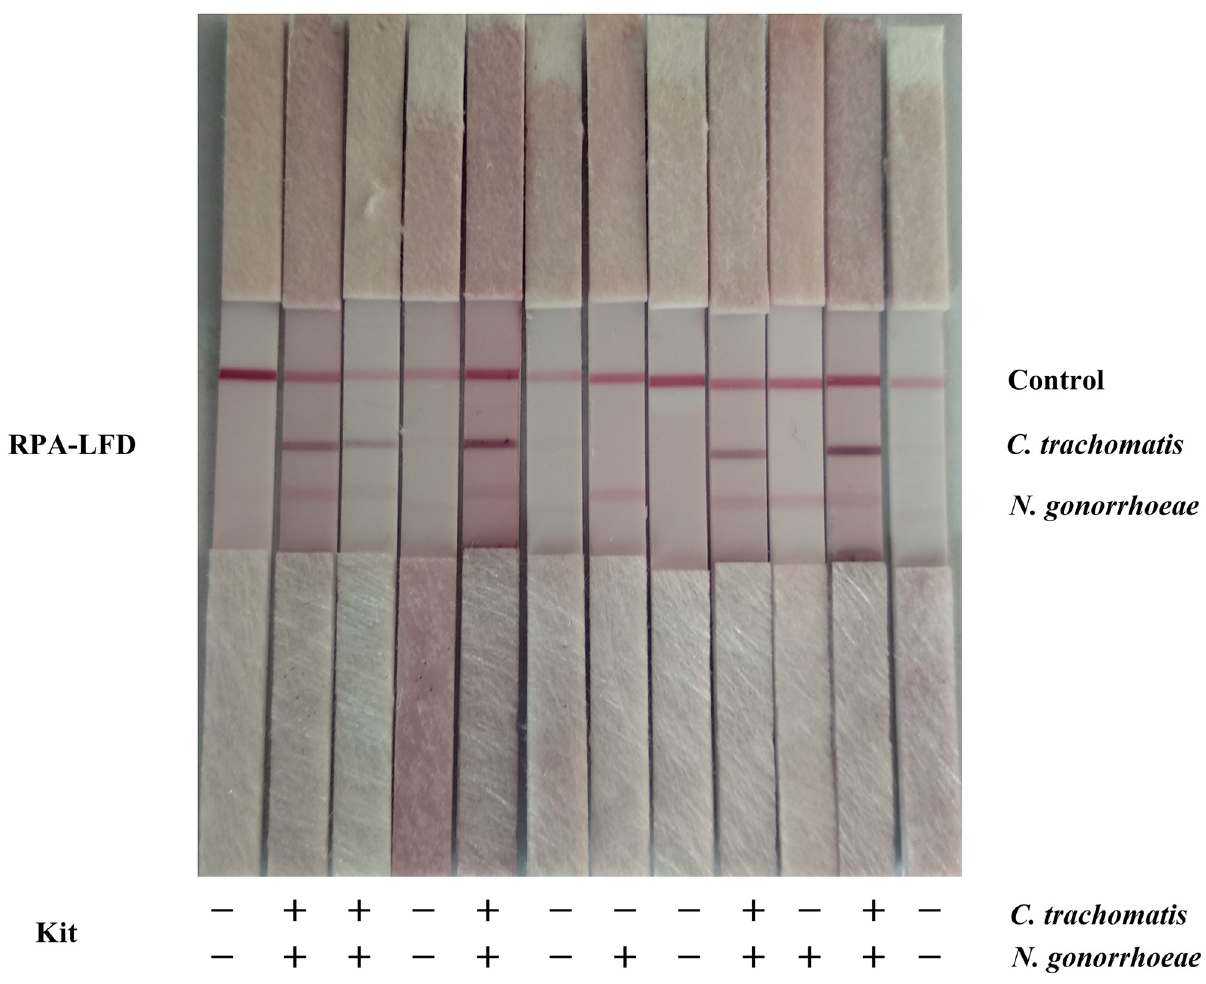
Fig 5. Randomly picked results of the multiplex RPA-LFD assay when used to assay clinical samples.